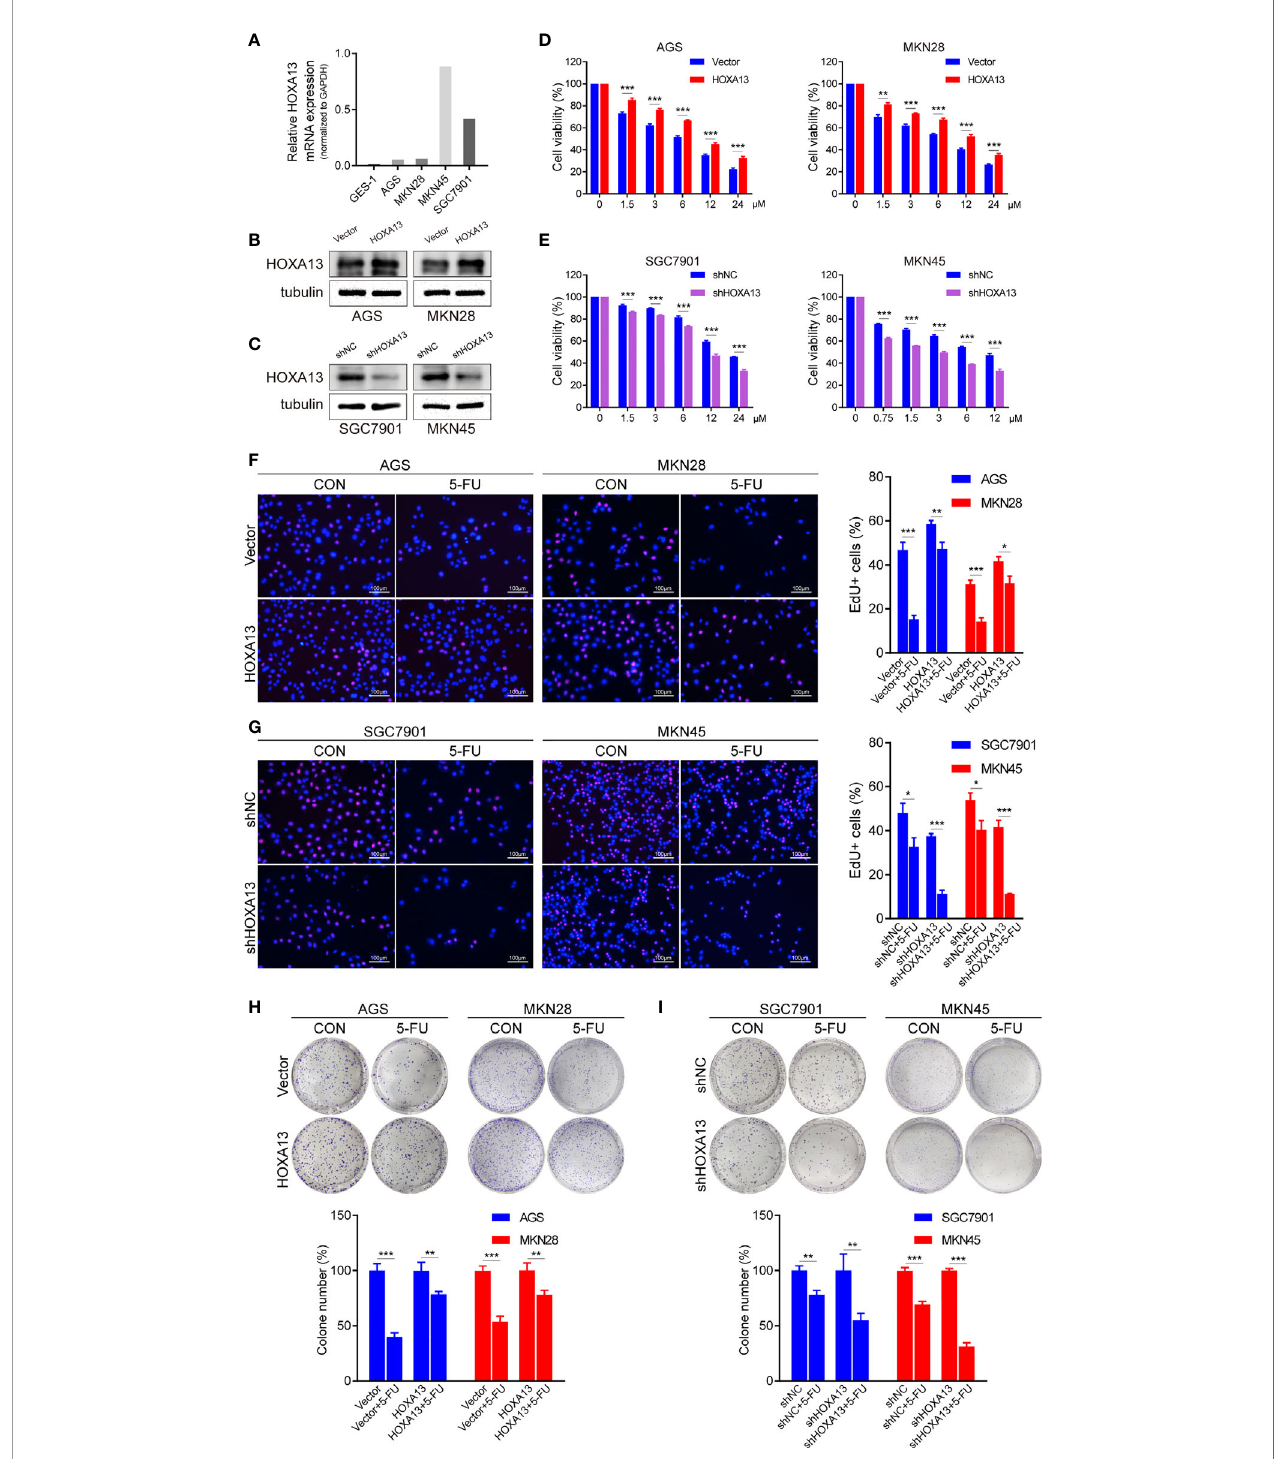
FIGURE 2 | HOXA13 promotes 5-FU resistance in GC cells. (A) Relative expression levels of HOXA13 in cell lines were detected by qRT-PCR. (B, C) The expression levels of HOXA13 were veri fi ed by Western blot in GC cells after transfection. (D, E) CCK-8 assays detected relative cell viability of GC cells with various concentrations of 5-FU. (F G) The rates of EdU staining in HOXA13+5-FU groups were higher than those of Vector + 5-FU groups, while knockdown of HOXA13 had the opposite effect. Magni fi cation ×200. (H, I) After 5-FU treatment, the relative colony formation rates of HOXA13-overexpressing cells were higher than that of Vector groups, while the relative rates of colonies were reduced in HOXA13 knockdown cells. * P < 0.05, ** P < 0.01, *** P <